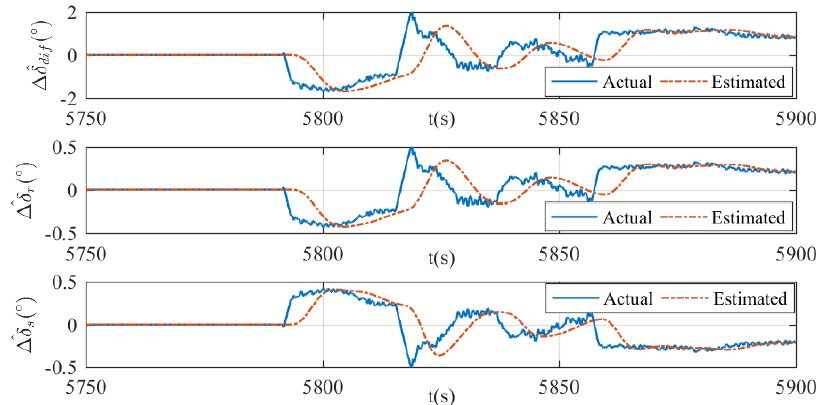
Figure 21. Estimation of ∆ u in case 3. The estimated di ff erential angle (top), the estimated virtual vertical rudder angle (middle), and the estimated virtual horizontal rudder angle (bottom).